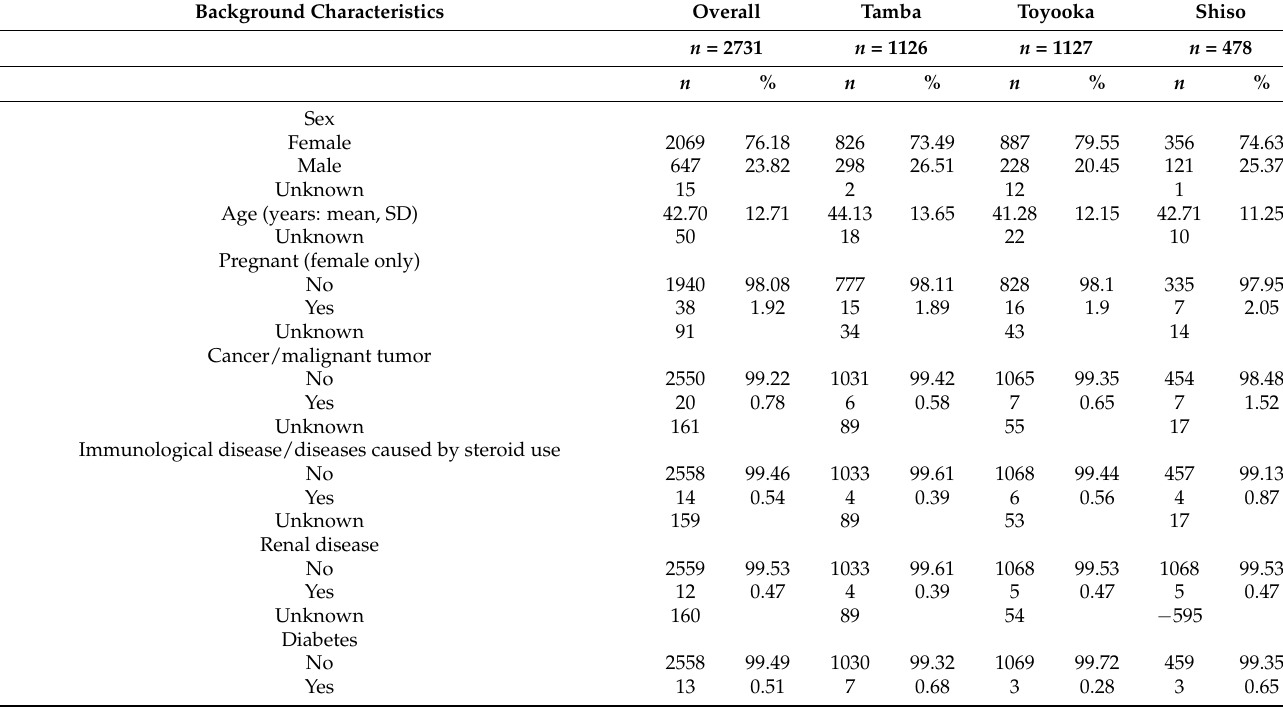
Table 1. Participants’ background characteristics during the 2018–2019 and 2019–2020 winter seasons. Background